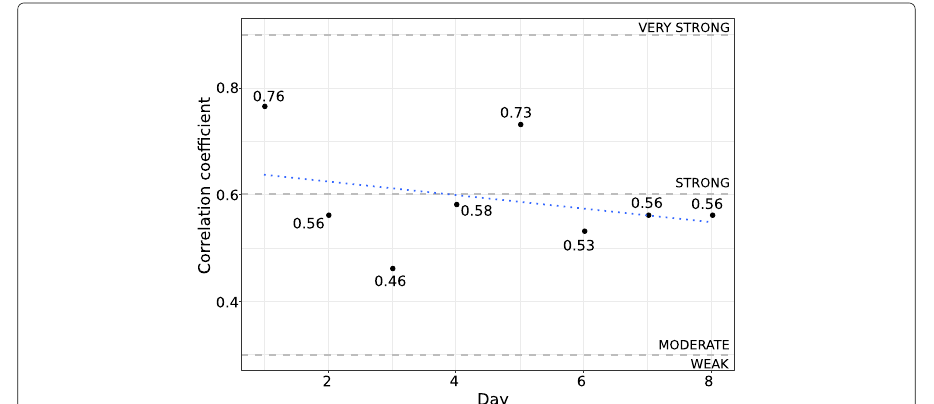
Fig. 5 Time-varying Kendall’s τ rank coefficient averaged for the five events